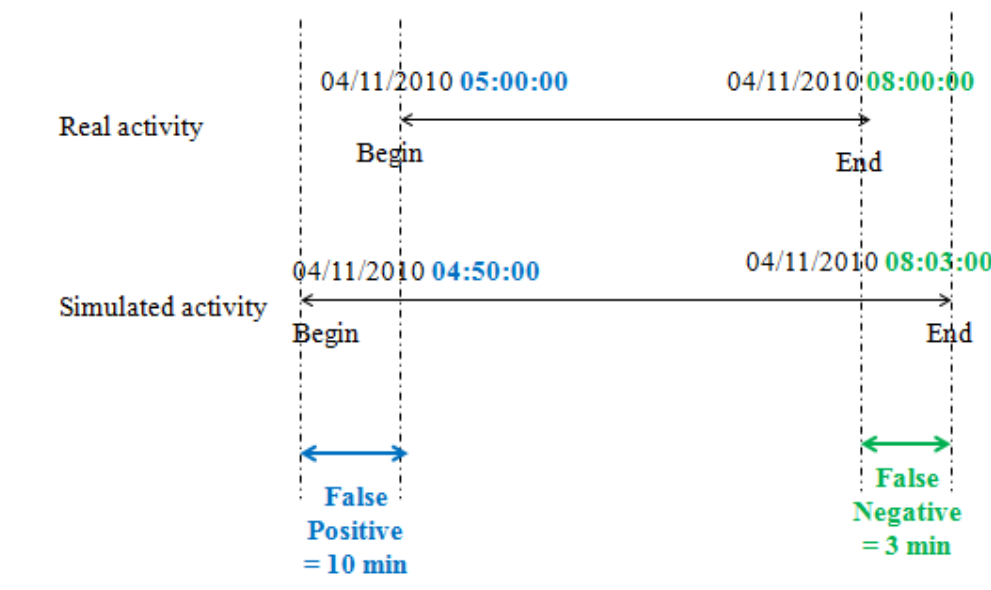
Figure 7. Precision and